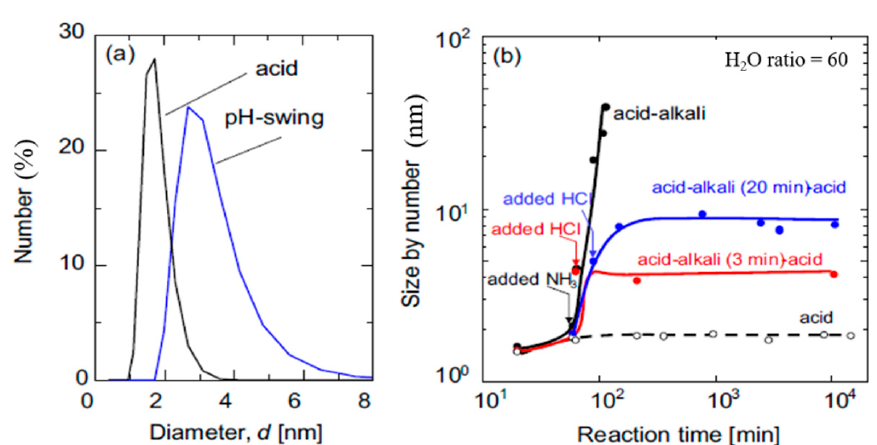
Figure 5. ( a ) Dynamic light scattering for pH-swing sol and acid sols. ( b ) Time course of BTESE-derived sols in acid, acid-alkali and acid-alkali-acid. Reproduced from [39] .